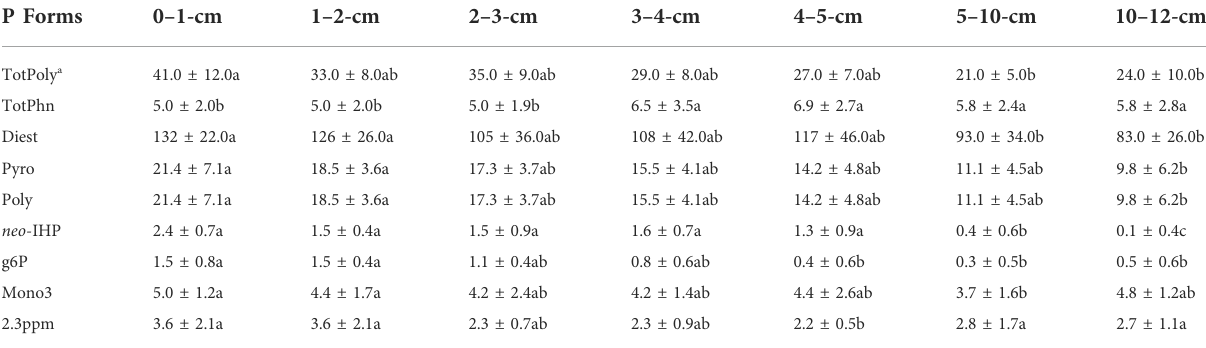
TABLE 4 Concentrations (mg P kg − 1 dry weight) of sediment P compound classes and P species in NaOH-EDTA extracts of sediments analyzed by P-NMR spectroscopy. Values are means (±SD); n = 8 (4 lakes, duplicate cores). Different letters indicate signi fi cant ( p < 0.05) differences in concentrations of P compound class and P species among depths, determined by two-way ANOVAs followed by Tukey HSD post-hoc tests using centred-log ratio